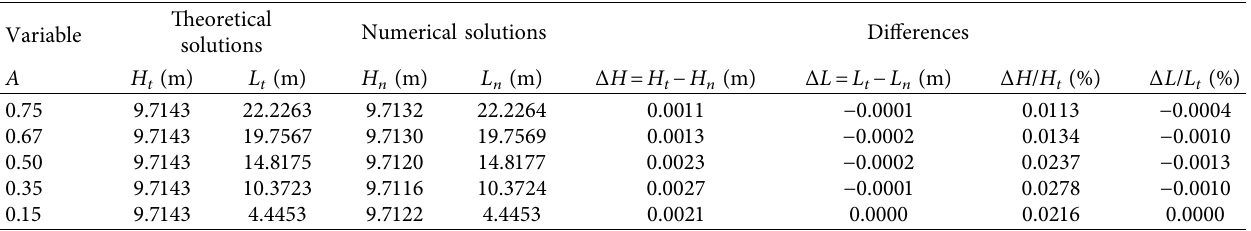
Table 2: Comparison of height H and width L of collapse block between theoretical solutions and numerical solutions with varied parameter A.